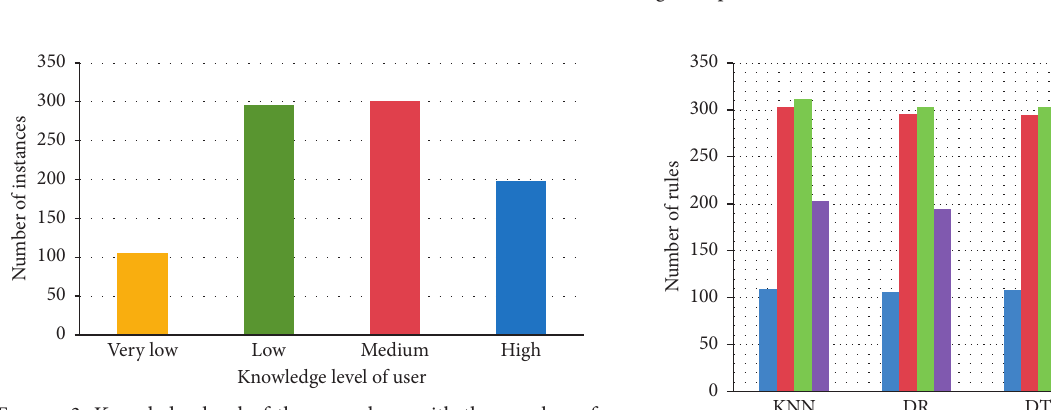
Figure 3: Knowledge level of the user along with the number of instances.